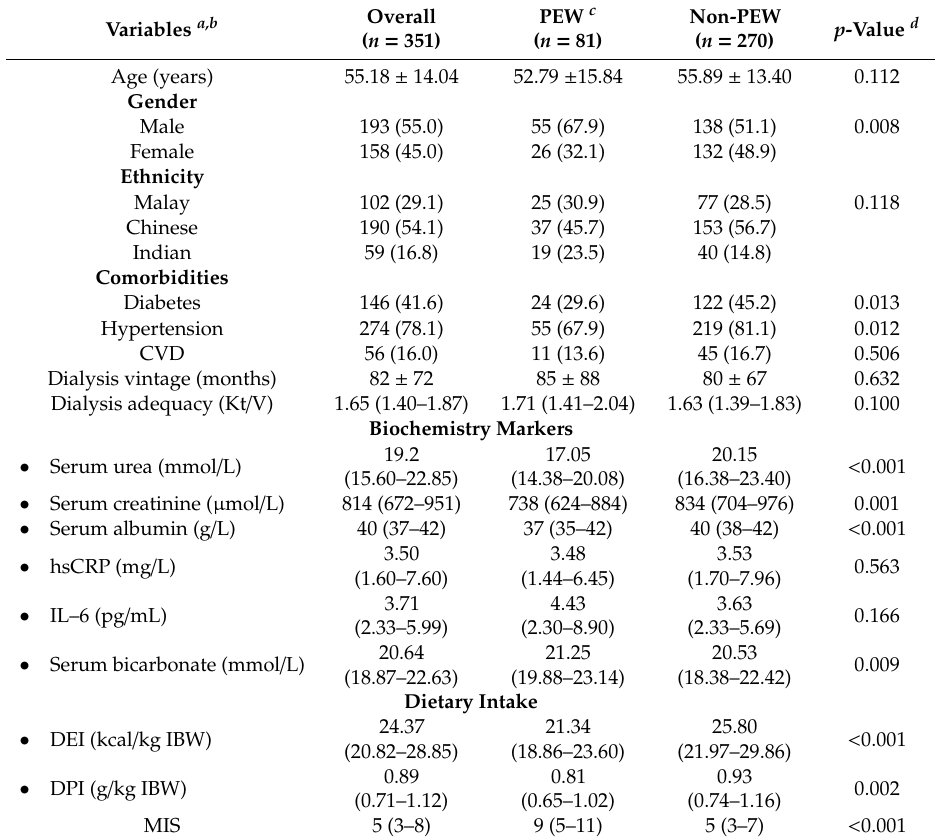
Table 1. Patient characteristics as per PEW